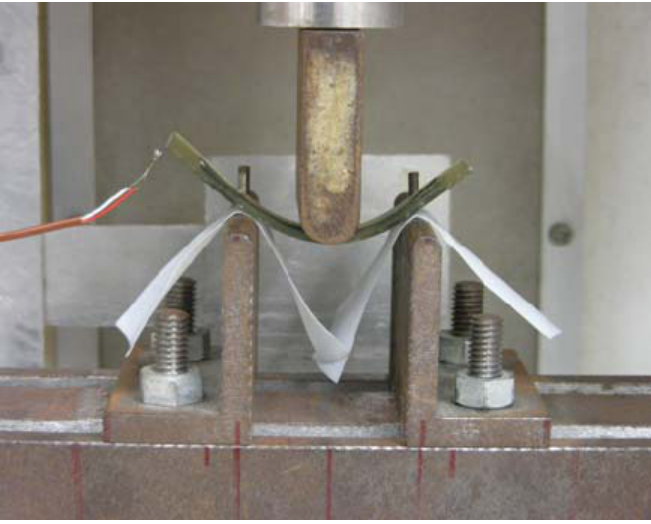
Figure 8. Photograph of the SMC belt kept in the bent form during heating and cooling in the three-point bending